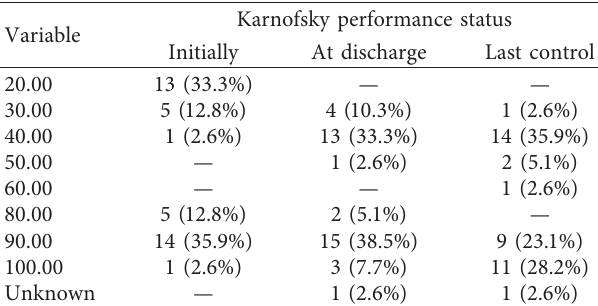
Table 4: The Karnofsky Performance Status of our